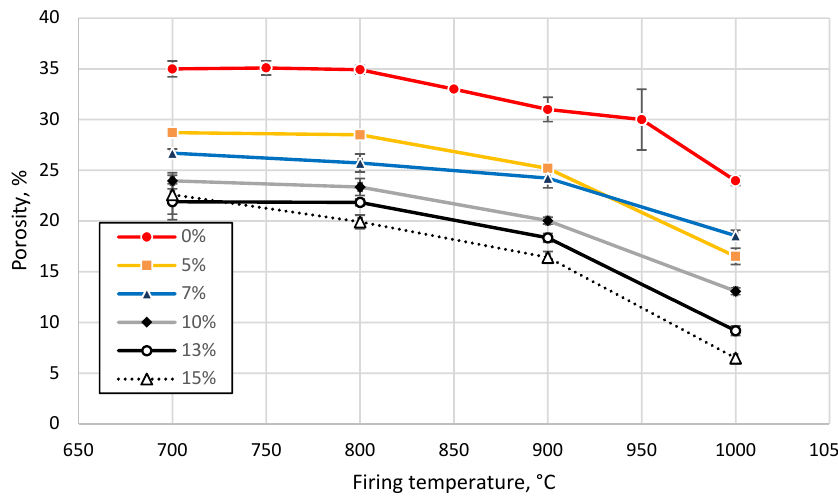
Figure 8. Apparent porosity of tested clay-glass ceramic materials after sintering at temperatures from 700 up to 1000 °C. The content of glass in wt% is in the legend.